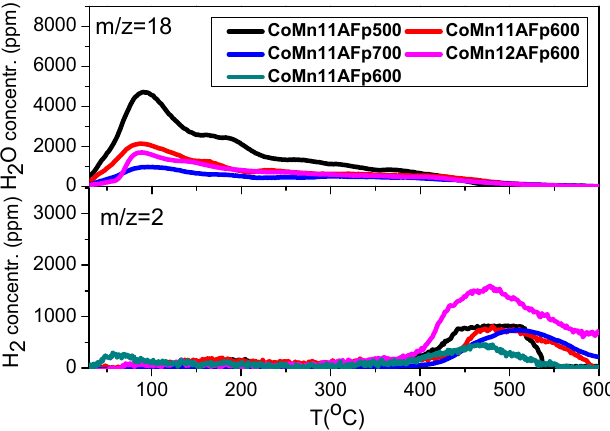
Figure 4. TPD profiles of H 2 O and H 2 after water adsorption at 25 °C over pyrolyzed catalysts.